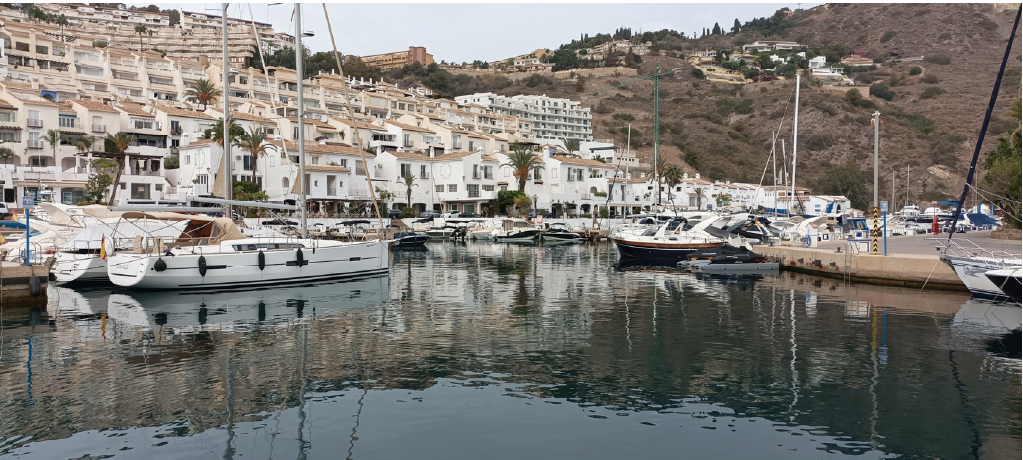
Figure 5. View from the port, with urbanization in the background (photograph by authors, October 2022).